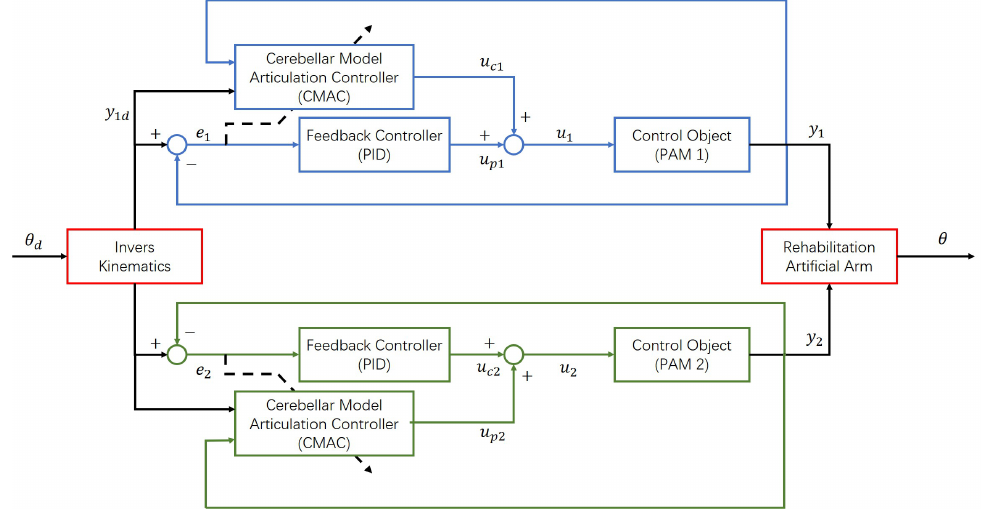
Figure 7. Adaptive motion controller by feedforward–feedback control scheme for manipulator in antagonistic